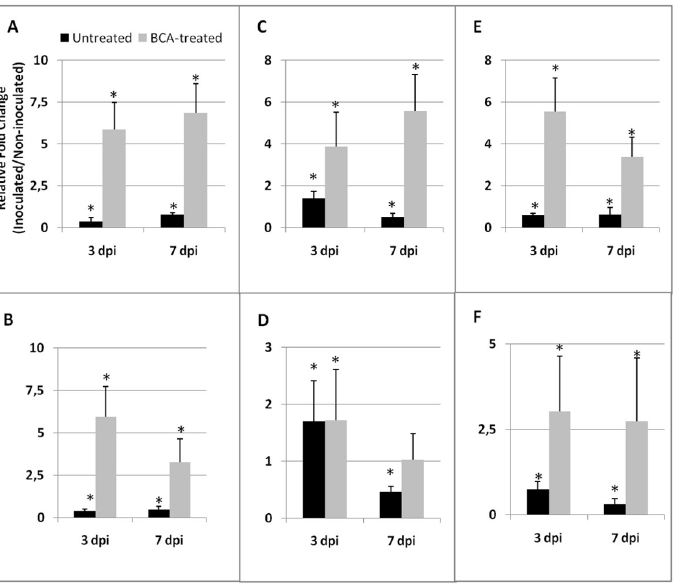
uninoculated roots in roots both at 3 and 7 dpi; in this case, BCA treatment resulted in a dras- tic (3 dpi) or limited (7 dpi) reduction of such an over-expression (Fig 4C). On the contrary, leaves were not involved in the activation of this gene: nematode inoculation to untreated or to BCA-treated plants did not change CAT gene expression with respect to healthy control plants (Fig 4D). BCA treatment systemically primed ACO gene expression against nematodes (Fig 4E and 4F), as it occurred with the PR -genes tested. Also in the absence of BCAs, nematode infec- tion induced an increase of transcript levels of the gene, although much slighter than in their presence.